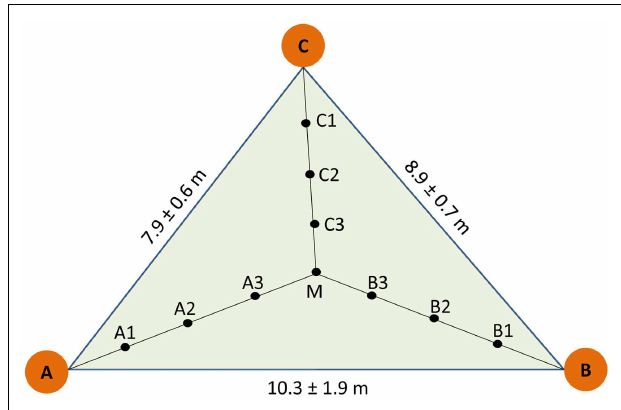
FIGURE 1 | Scheme of sampling design . A, B, and C indicate the position of the target trees used to construct the sampling triangle.Three plots were selected and distances indicate mean of the three plots. Soil cores were collected at equidistant positions within the triangle (A1A2 = A2A3 = A3M = 1.4 ± 0.2m, B1B2 = B2B3 = B3M = 1.3 ± 0.3m, C1C2 = C2C3 = C3M = 1.2 ± 0.1m).